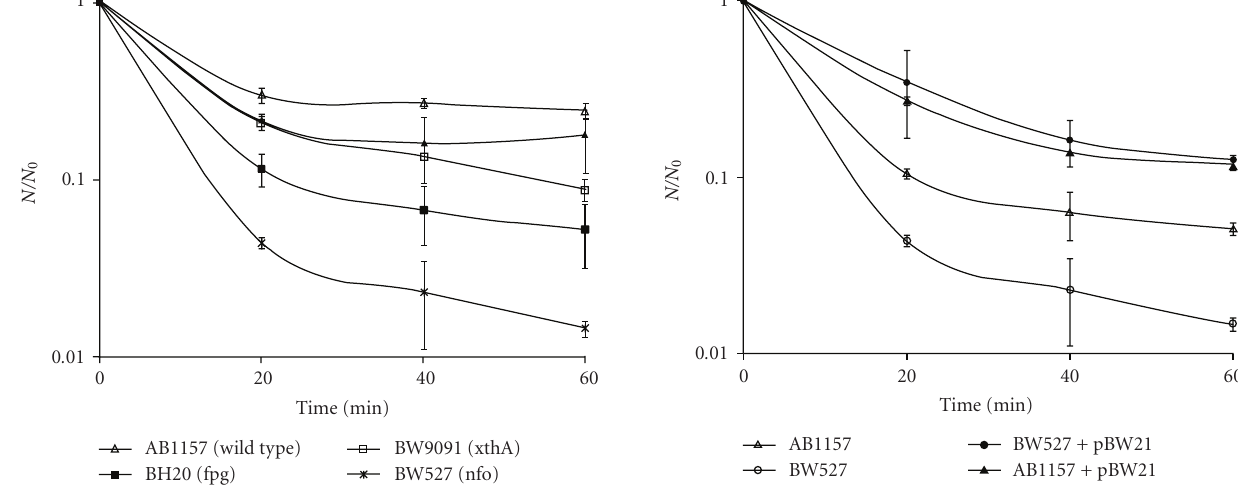
Figure 4: Survival fraction of E. coli AB1157, AB1157+pBW21, BW527, and BW527 + pBW21 treated with UVA and SnCl 2 . Mid- log phase cells suspended in 0.9% NaCl were illuminated with 90 kJ/m 2 UVA, followed by SnCl 2 (25 μ g/mL), for di ff erent incubation times and the specific survival fractions. Survival fraction values are means ± standard deviations of the three isolated